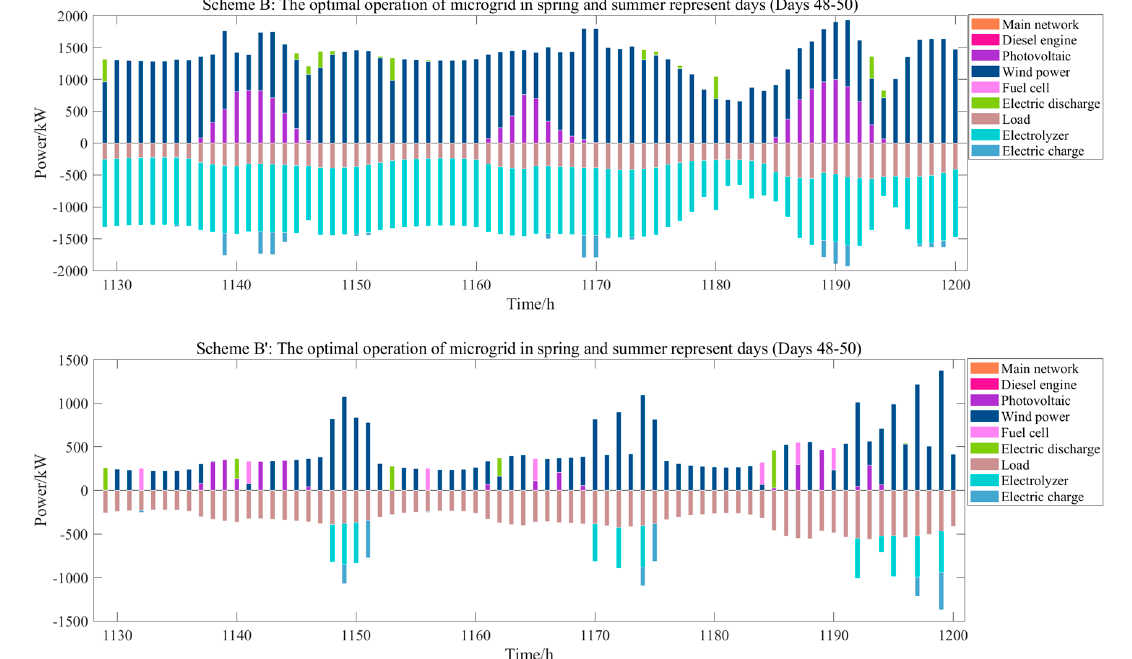
Figure 8. The optimal operation of the microgrid with two schemes in spring and summer represents day (Days 48 − 50).